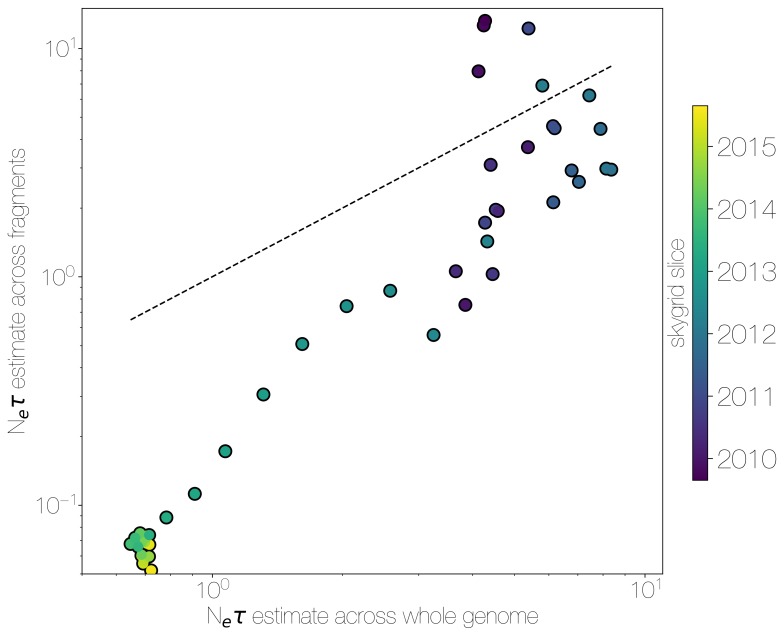
Skygrid comparison between whole and fragmented genomes.Inferred median Ne⁢τ recovered using a skygrid tree prior on whole genome (bottom) and ten genomic fragments with independent trees (left), coloured by time. Dotted line indicates the one-to-one line.